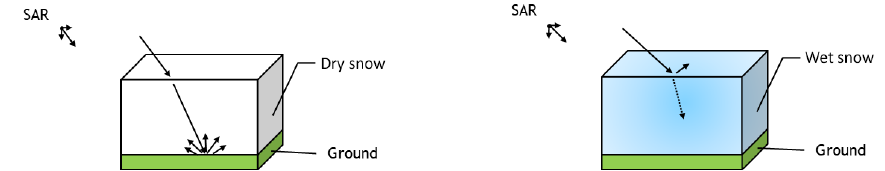
Figure 2. Main SAR backscattering mechanisms in presence of dry and wet snow at the C band. The dry snow is almost transparent, and the radar echo can penetrate the snow for several meters. The presence of LWC causes high dielectric loss, which increases the absorption coefficient.